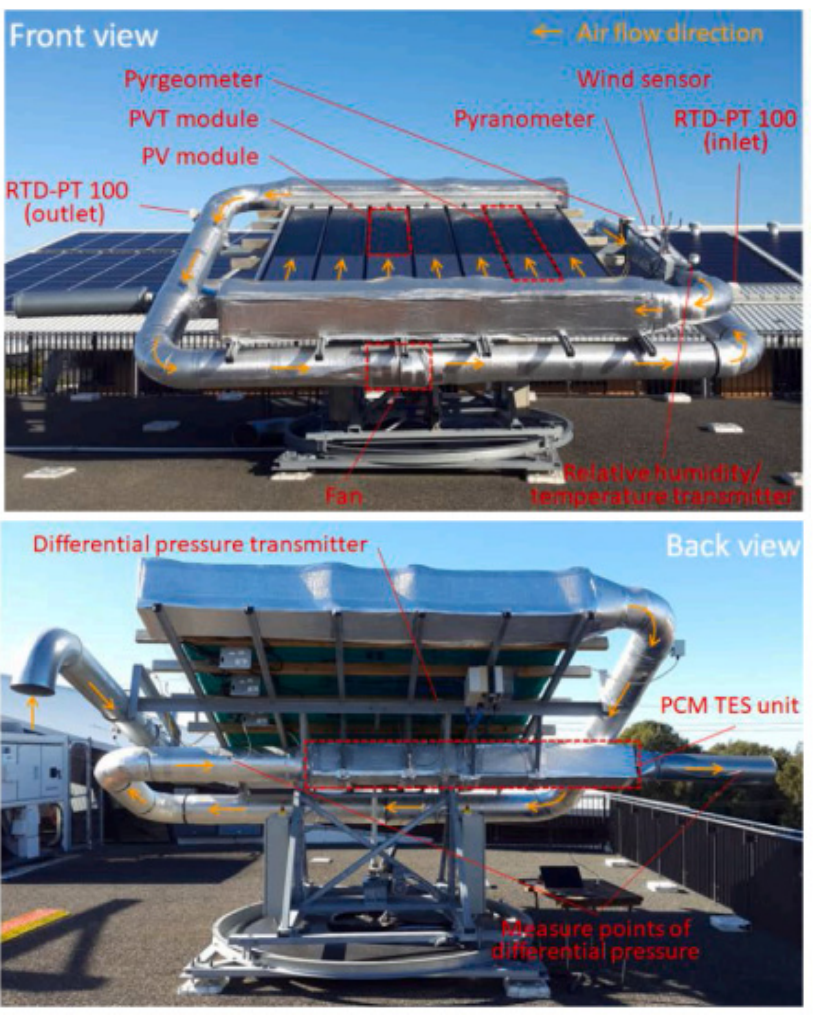
Figure 9. Diagram of the experimental setup presented by Lin et al. [34]. Adapted with permission from Elsevier.